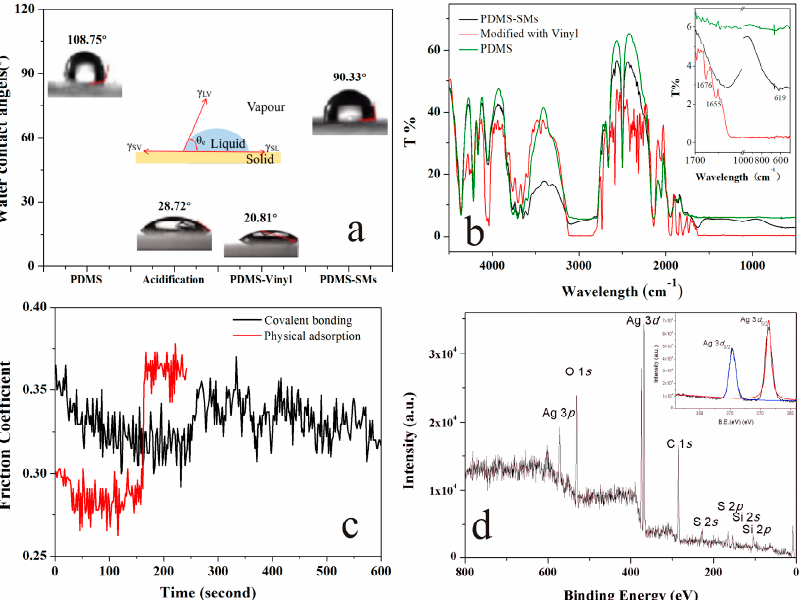
Figure 2. ( a ) Water contact angle (WCA) measurement of the PDMS and functionalized PDMS strip. ( b ) Fourier Transform infrared (FTIR) spectra of the PDMS (green line), PDMS-vinyl (red line) and PDMS-SMs (black line). ( c ) Effects of SMs modified PDMS on friction coefficient. The SMs were assembled on the surface of PDMS by covalent bonds (black line) or physical adsorption (red line); ( d ) X-ray photoelectron spectroscopy (XPS) survey spectrum of the SMs-AgNPs (insert: Ag 3d spectrum).